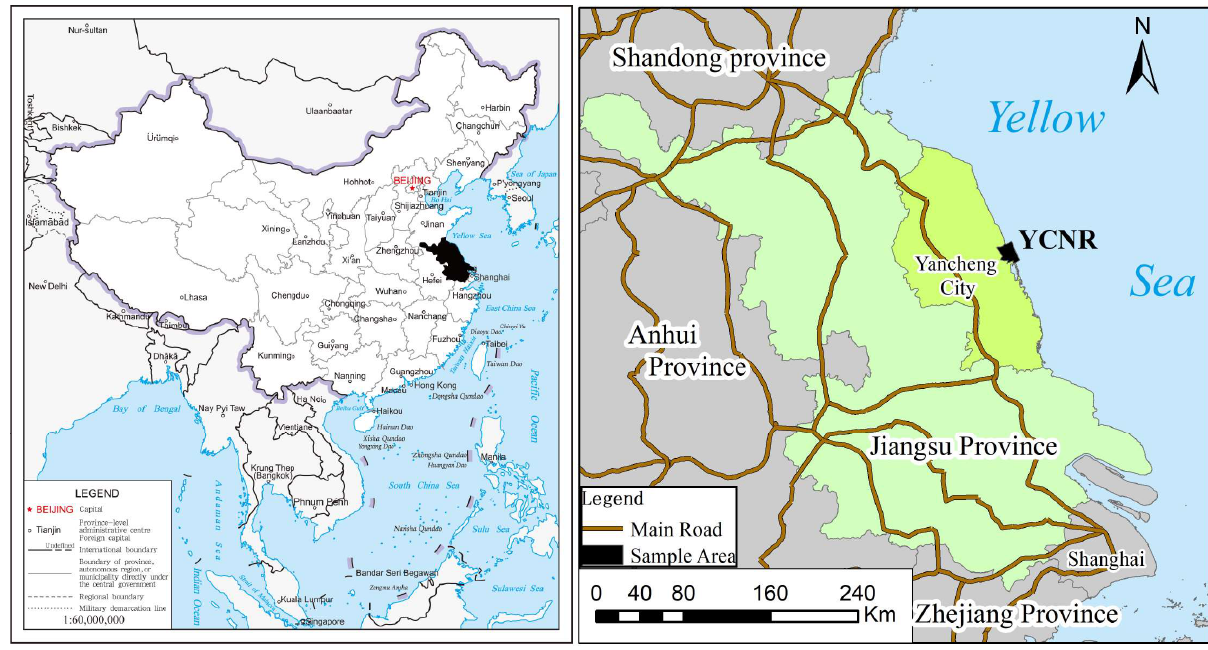
Figure 1. Map of the study